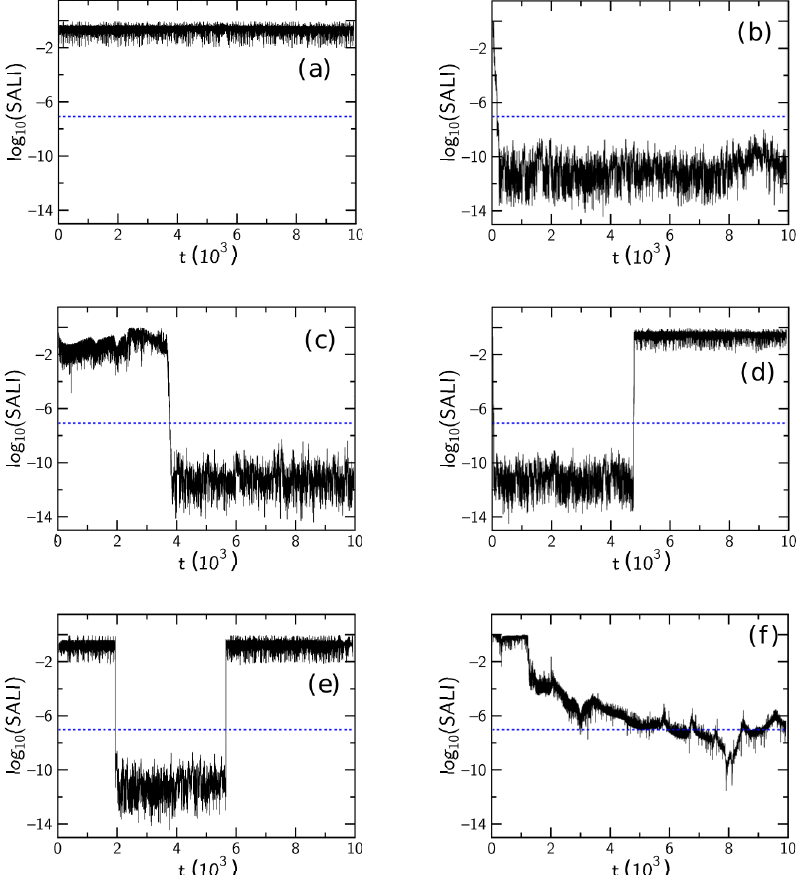
Fig. 6. Time-evolution of SALI for six different types of orbits in the time-dependent Hamiltonian. Details are given in the text. is transported from the disk and a massive nucleus is developed in the